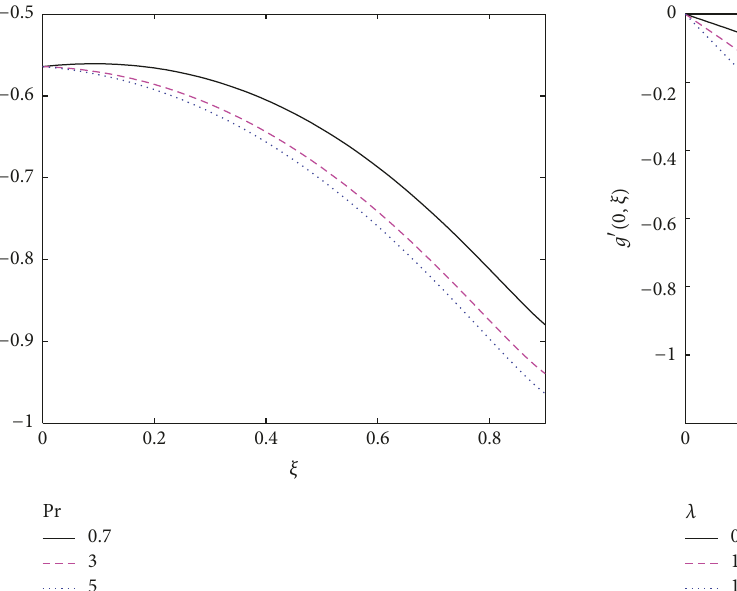
Figure 14: Effect of 𝜆 on 𝑔 󸀠 (0,𝜉) . ( 𝜎 = 𝛾 = 0.5, Pr = 3, Sc = 2, ℏ = −0.5 ).